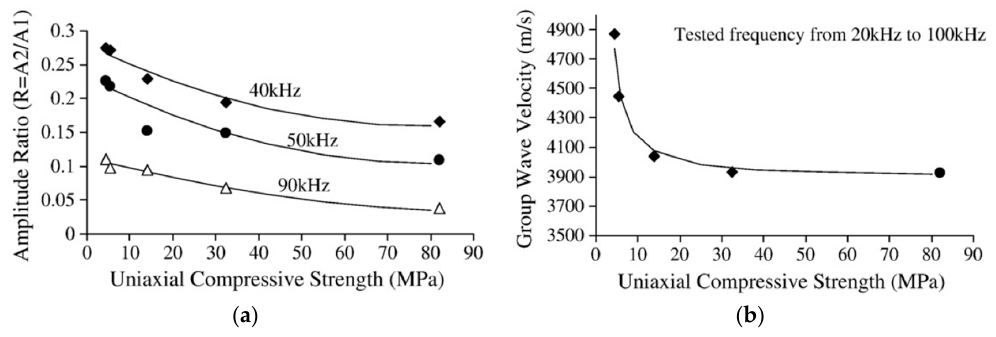
Figure 19. ( a ) Variation of amplitude ratio with grout compressive strength at different wave frequencies; ( b ) Variation of average group velocity with grout compressive strength [60].